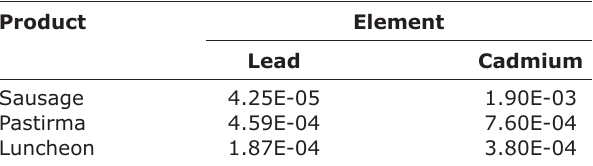
Table-7: The carcinogenic risk of lead and cadmium through the consumption of meat products.